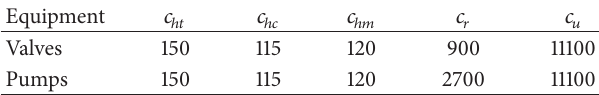
Table 4: Components reliability parameters. Table 5: Components cost information